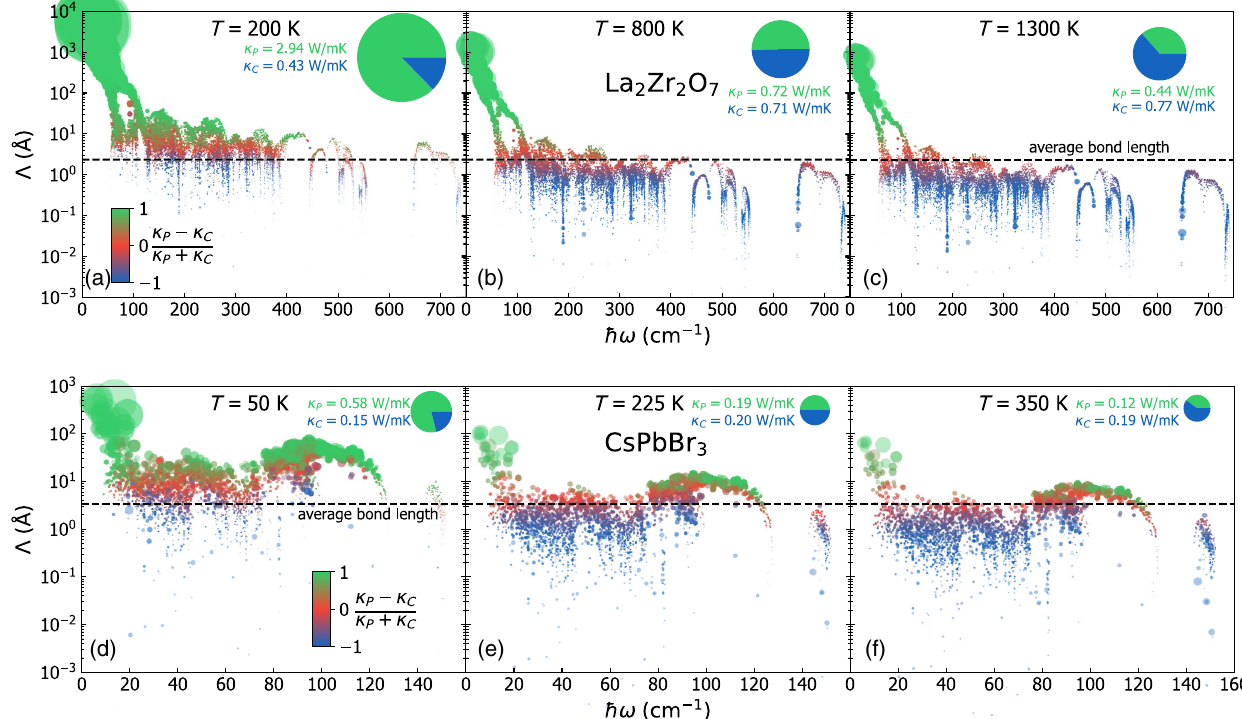
FIG. 9. Phonon mean free paths (MFP) in La 2 Zr 2 O 7 and CsPbBr 3 . We plot the phonon mean free paths Λ ð q Þ s ¼ v av ð q Þ s;s τ ð q Þ s as a function of the energy ℏ ω ð q Þ s for La 2 Zr 2 O 7 [at a temperature of 200 K (a), 800 K (b), and 1300 K (c)], and for CsPbBr 3 [at a temperature of 50 K (d), 225 K (e), and 350 K (f)]. The area of each circle is proportional to the contribution to the total conductivity and colored according to the origin of the contribution: green for particlelike propagation of populations; blue for wavelike tunneling of coherences; intermediate colors represents phonons contributing to both mechanisms, with red corresponding to 50% of each [see Eq. (54)]. The dashed black line in panels (a) – (c) [(d) – (f)] is the average bond length in La 2 Zr 2 O 7 [CsPbBr 3 ]. We highlight how phonons at the center of the nonsharp crossover from dominant particlelike conduction to dominant wavelike conduction have a mean free path approximately equal to the average bond length (i.e., they are at the Ioffe-Regel limit in space [28,41]), a behavior which is explained by Eq. (55). The pie charts have an area proportional to the total conductivity, and the slices resolve the populations conductivity (particlelike, green) and the coherences conductivity (wavelike,